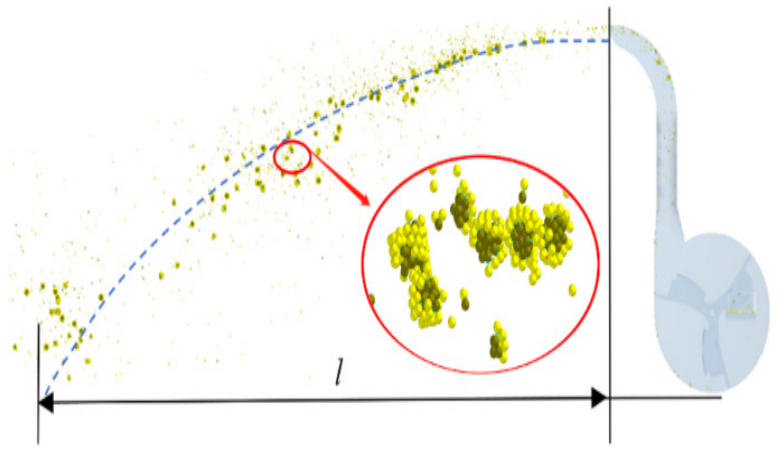
Figure 8. CFD − DEM coupled simulation cutting and throwing test.